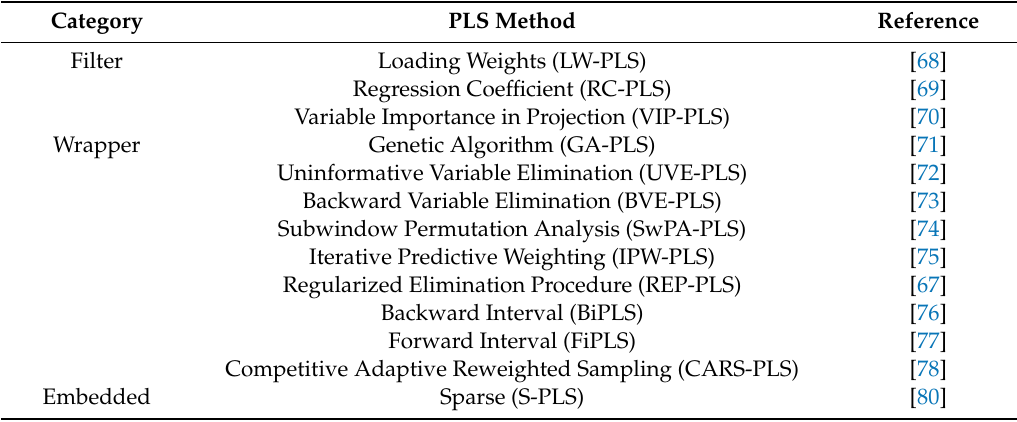
Table 1. Evaluated wavelength selection PLS methods.